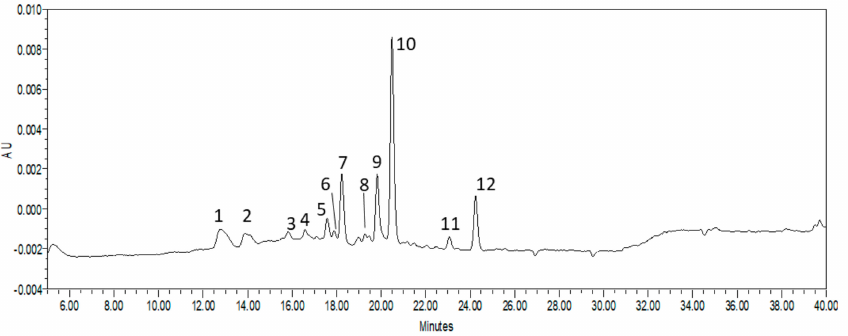
Figure 3. HPLC-DAD chromatogram of horse chestnut leaf extract (1: catechin; 5: Quercetin–3– O – galactoside; 6: Quercetin–3– O –glucoside; 10: Quercetin–3– O